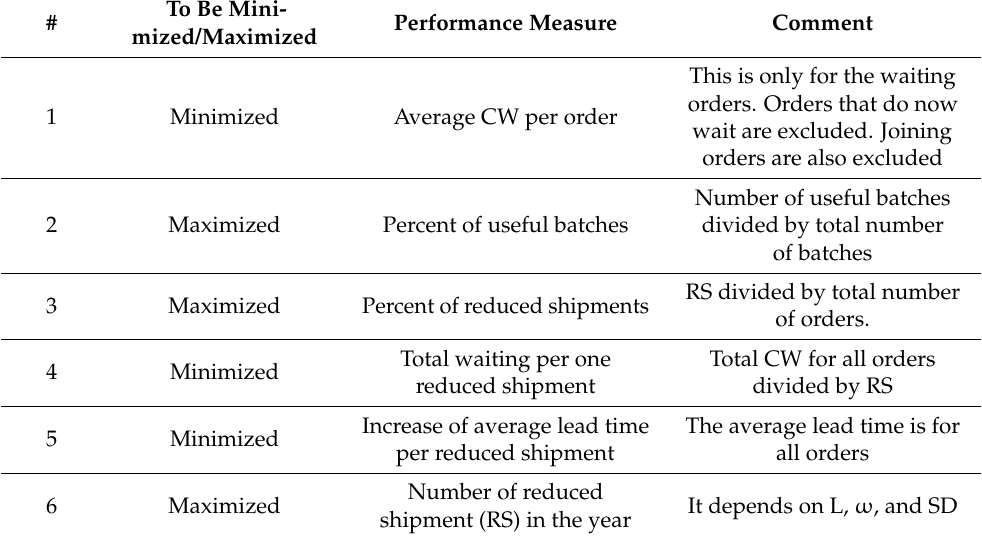
Table 2. Performance measures of simulation model.